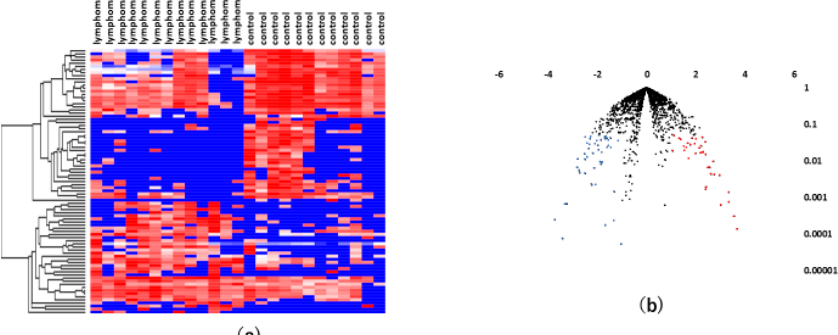
Figure 3. Analyses of serum miRNAs in VRL versus heathy controls. ( a ) Unsupervised hierarchical clustering analysis with a heatmap. The spectrum of dark red to dark blue color corresponds to high to low values. ( b ) Volcano plot of the fold change of miRNAs. Blue dots indicate downregulation, red dots indicate upregulation of miRNA and black dots indicate no significant difference.